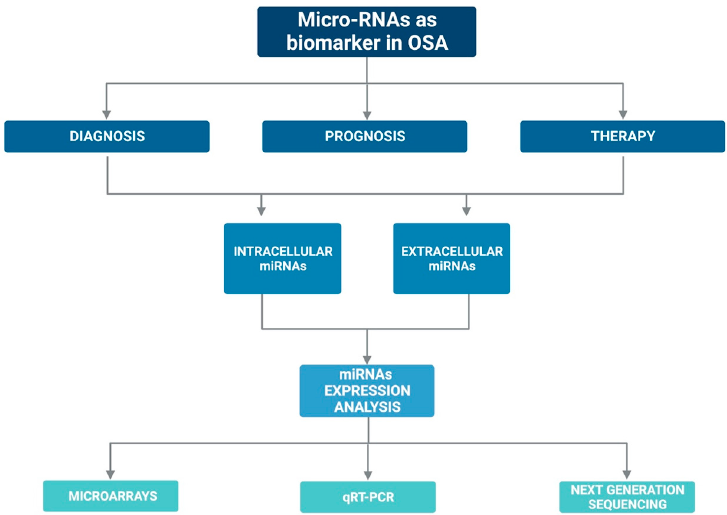
Figure 2. Graphic representation on the possible role of miRNAs as biomarkers in OSA.